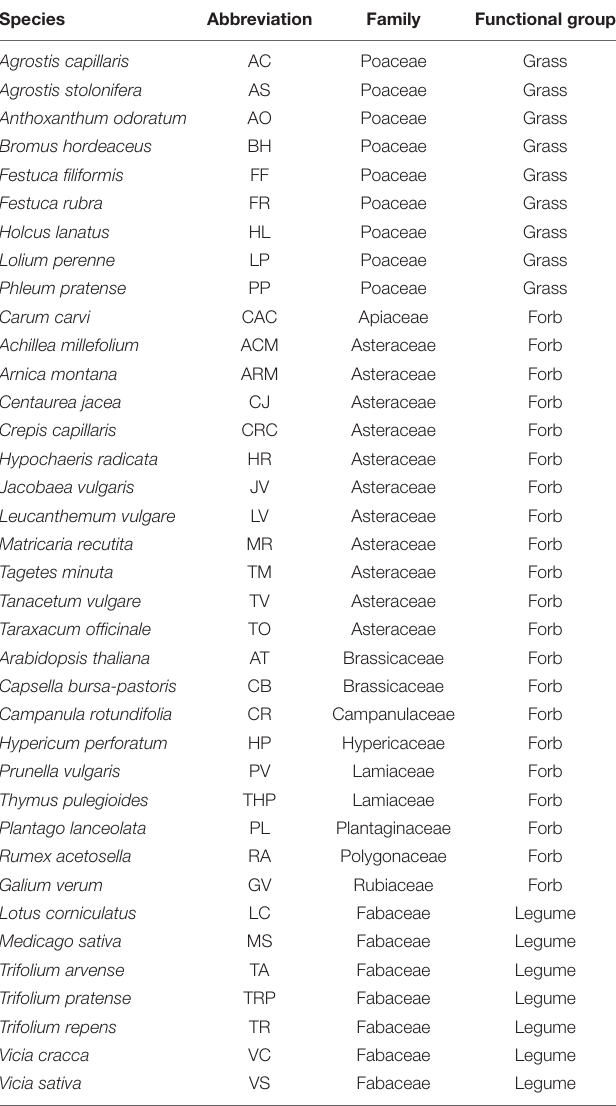
TABLE 1 | List of plant species used in the conditioning phase, their abbreviation used in the manuscript, family and functional group are also